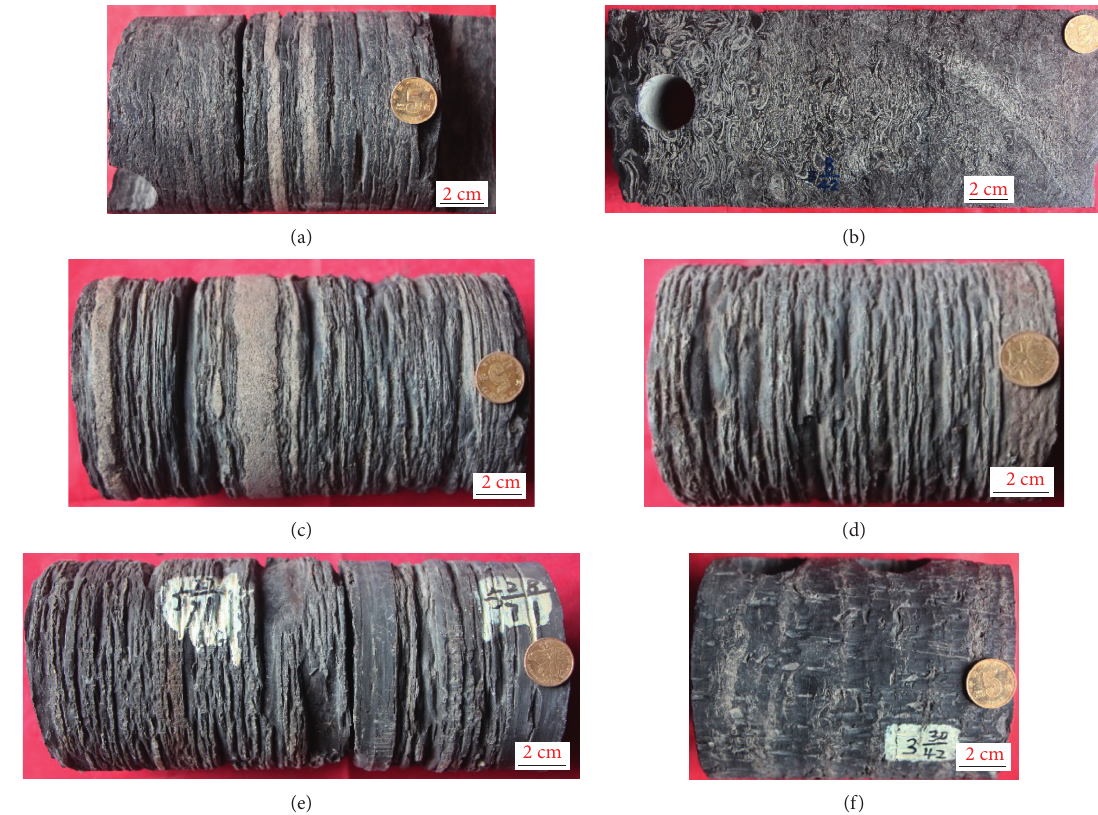
Figure 3: The lithology and laminar fracture of the fine-grained rock core of the Da’anzhai Member in the Sichuan Basin. (a) Shell limestone, shale intercalated with shale, lamina fractures developed, l North-1 Well, 3755.3m.(b) Argillaceous shell limestone, shells arranged along the lamina, East-2 Well, 2152.5m. (c) Intercalated limestone of gray-black shale, East-1 Well, 2618.23m. (d) Black shale, laminar, and laminar fractures, East-1 Well, 2620.45m. (e) Black shale, laminar and laminar fractures, East-1 Well, 2623.12m. (f) Lime mudstone, East-2 Well,